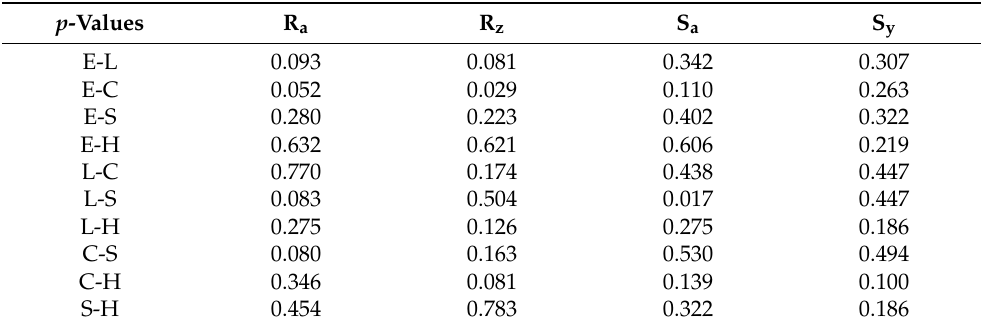
Table 8. p -Values related to material, after finishing. E (Enamic), L (Lava Ultimate), C (Cerasmart), S (Shofu), H